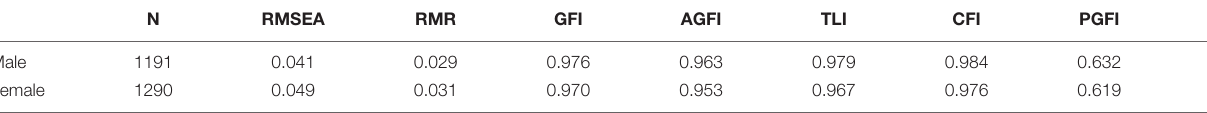
TABLE 5 | The goodness of fit index.